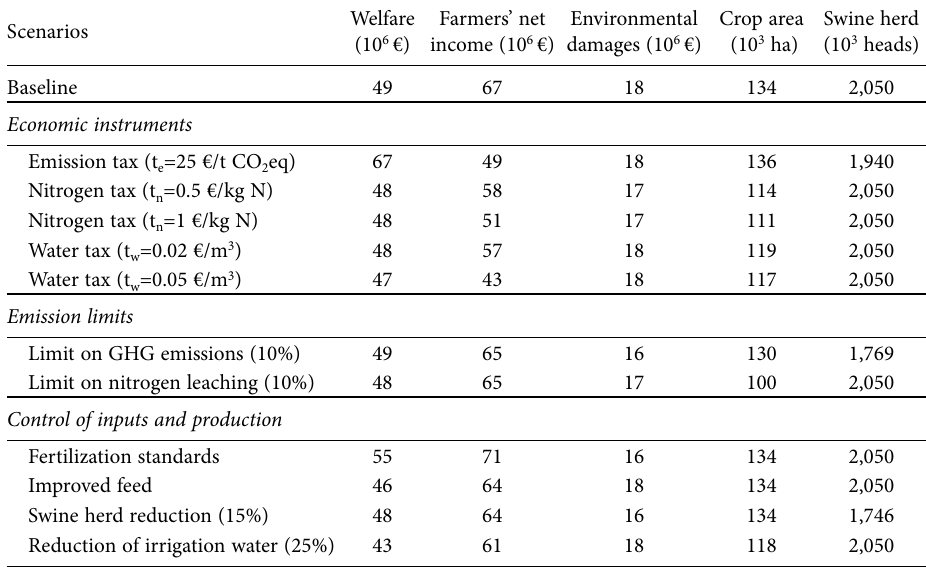
Table 3. Social welfare, net income and land use under each scenario. *